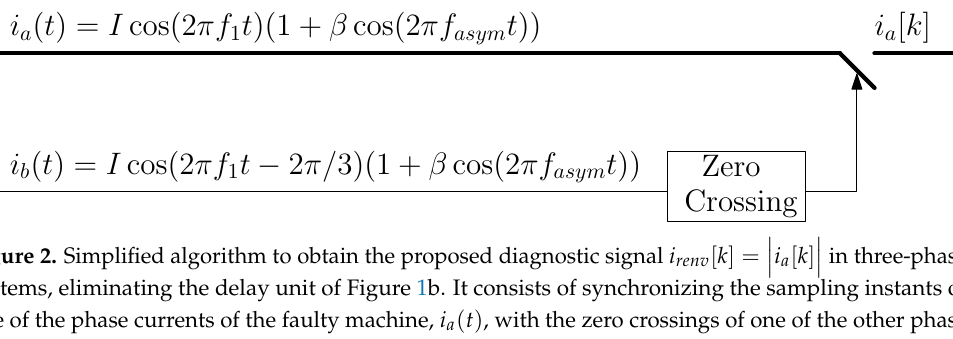
Figure 2. Simplified algorithm to obtain the proposed diagnostic signal i renv [ k ] = systems, eliminating the delay unit of Figure 1b. It consists of synchronizing the sampling instants of one of the phase currents of the faulty machine, i a ( t ) , with the zero crossings of one of the other phase currents, i b ( t ) , and taking its absolute value.